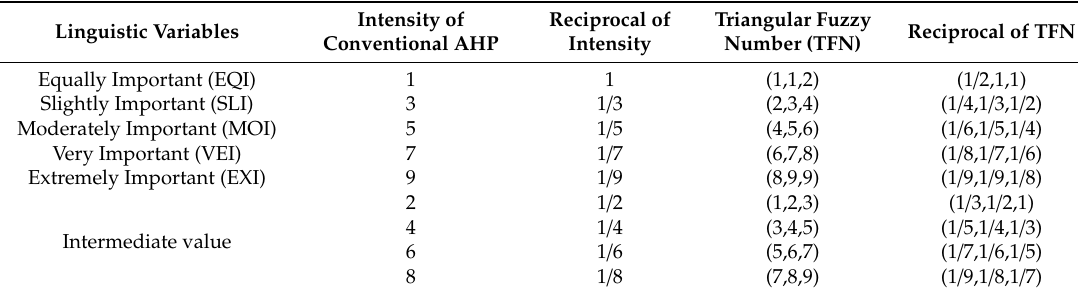
Table 2. Triangular fuzzy scale used in this